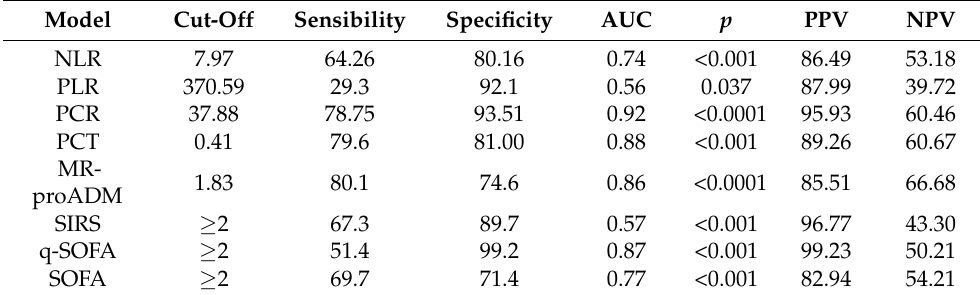
Table 3. Comparison of the diagnostic role of NLR with other inflammatory markers or clinical scores: positive predictive value (PPV) and negative predictive value (NPV).